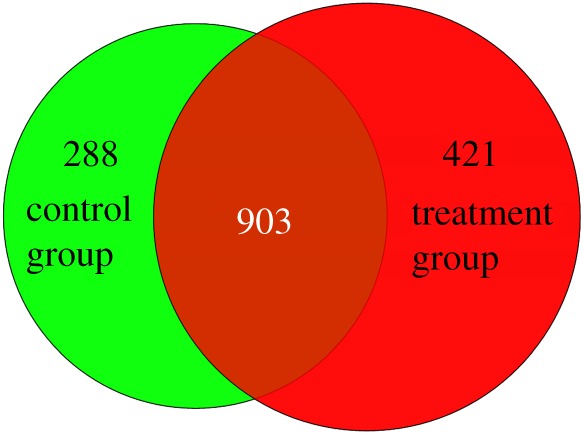
The differentially expressed genes that are uniquely or commonly expressed in control group (normal ewes) and treatment group (ovariectomized ewes) longissimus dorsi muscle samples. The numbers in each section indicate the number of differentially expressed genes.